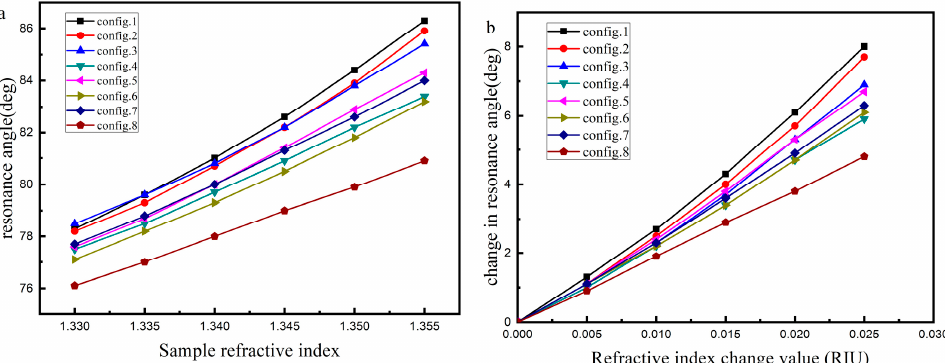
Figure 4. ( a ) The resonance angle and ( b ) the variation of resonance angle obtained by changing the refractive index of analyte.